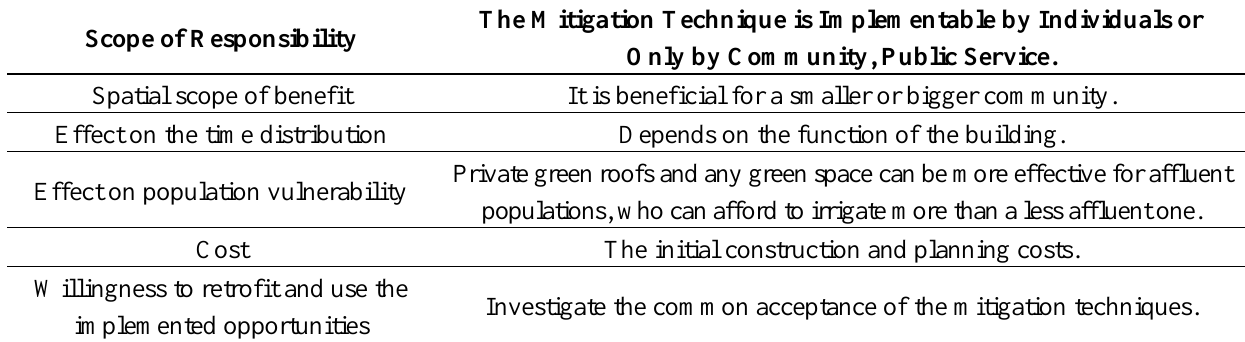
Table 2. Cool retrofitting